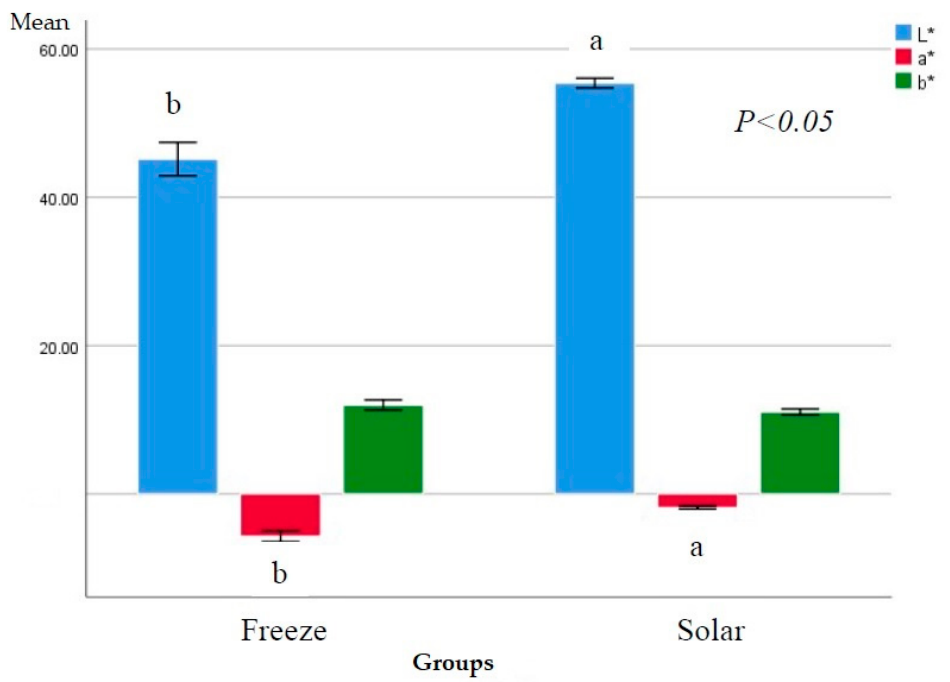
Figure 1. Color traits (L*a*b*) of freeze- and solar- dried O. syriacum. Different superscript letters for the same color index of freeze- and solar- dried O. syriacum are significantly different ( p ≤ 0.05).